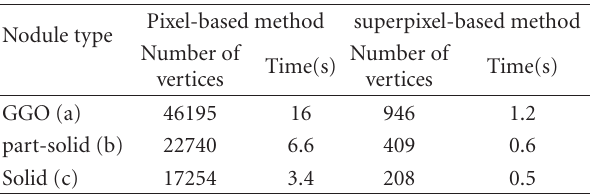
Table 1: Comparison of pixel-based and superpixel-based graph cut algorithms on three di ff erent types nodules.